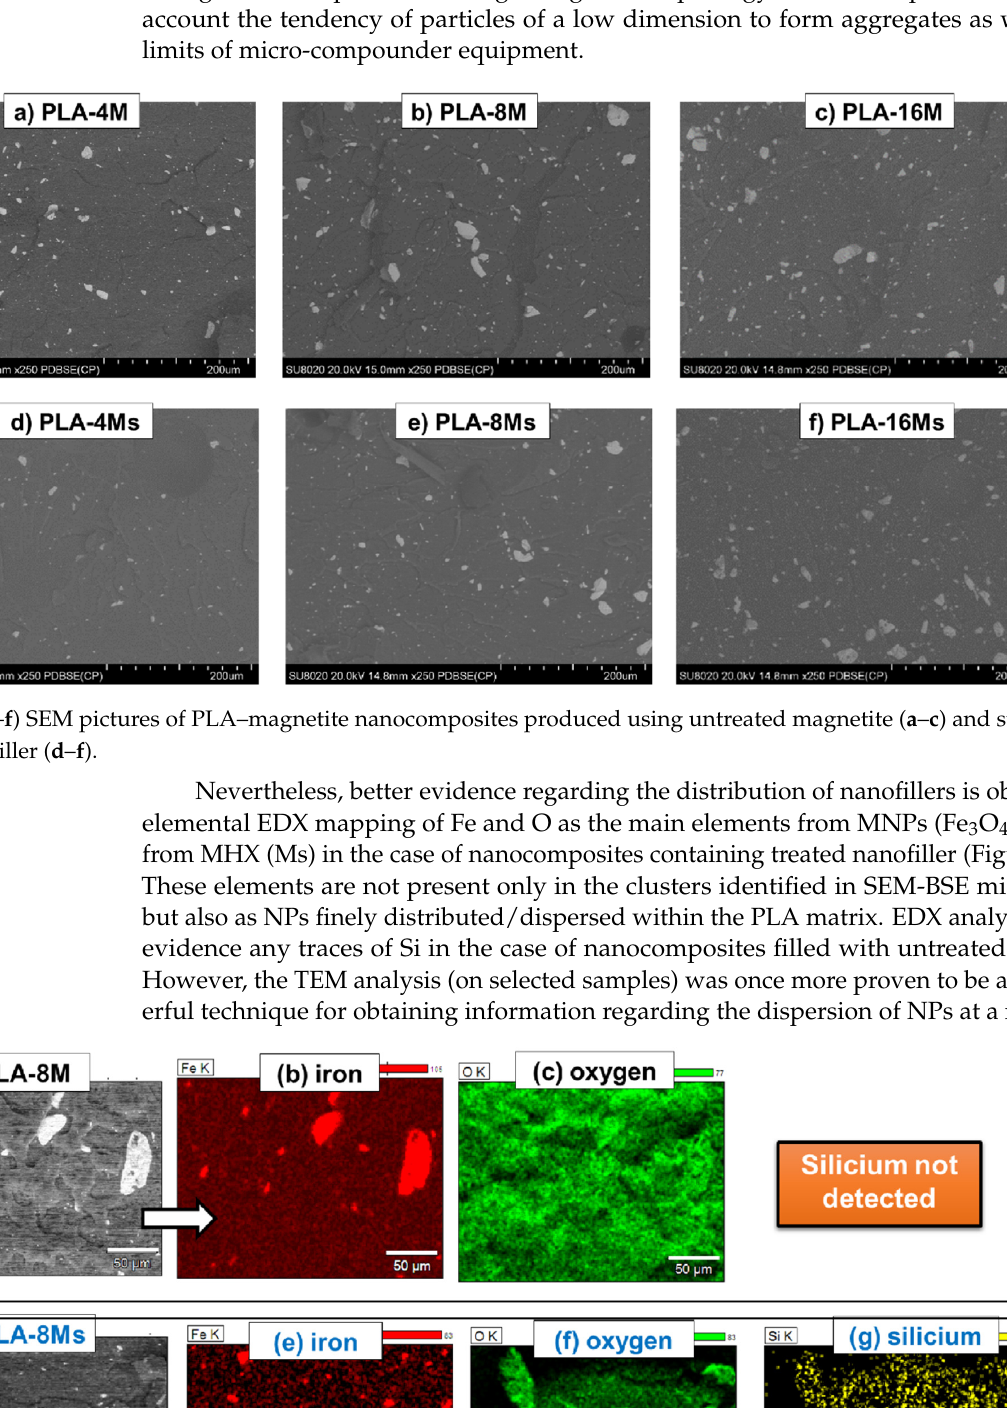
Figure 12. ( a – c ) TEM pictures at different magnifications of PLA–4% magnetite nanocomposites produced using untreated ( a , b ) and surface treated MNPs ( c , d ).